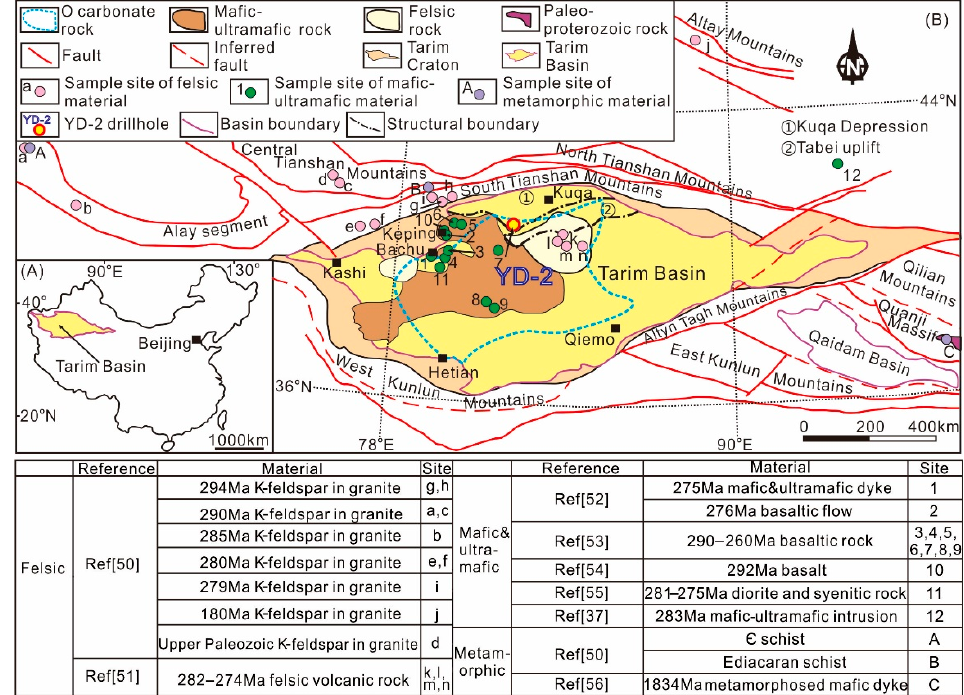
Figure 8. ( A ): Simplified map showing the location of the Tarim Basin in China; ( B ): A map showing sample sites for Pb and Sr isotope data from published studies used for comparing with Pb-Sr isotope data for pyrites in this study. Є— Cambrian; O—Ordovician; a–n—Sample sites of felsic material (e.g., granite); 1–12—Sample sites of mafic-ultramafic material (e.g., basalt); A–C—Sample sites of metamorphic material (e.g., schist).